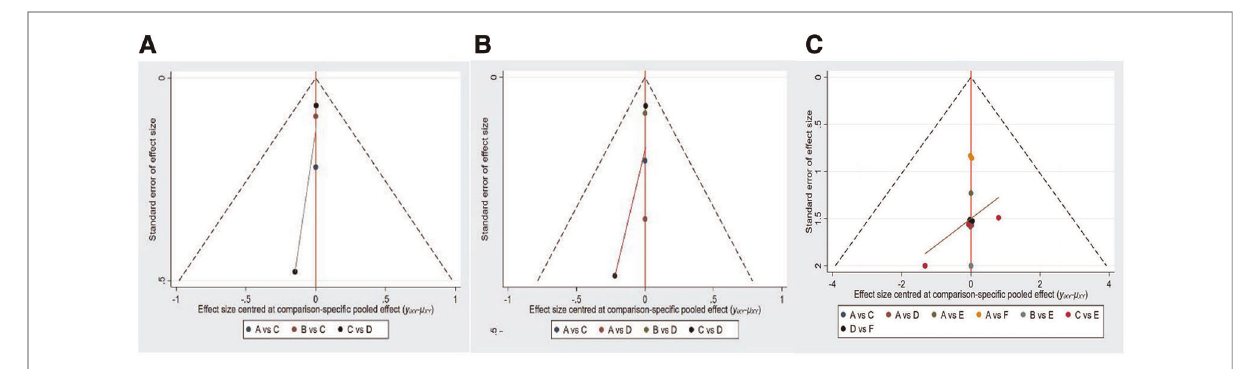
FIGURE 7 Funnel plot on publication bias ( A ) FR ( B ) CP ( C )